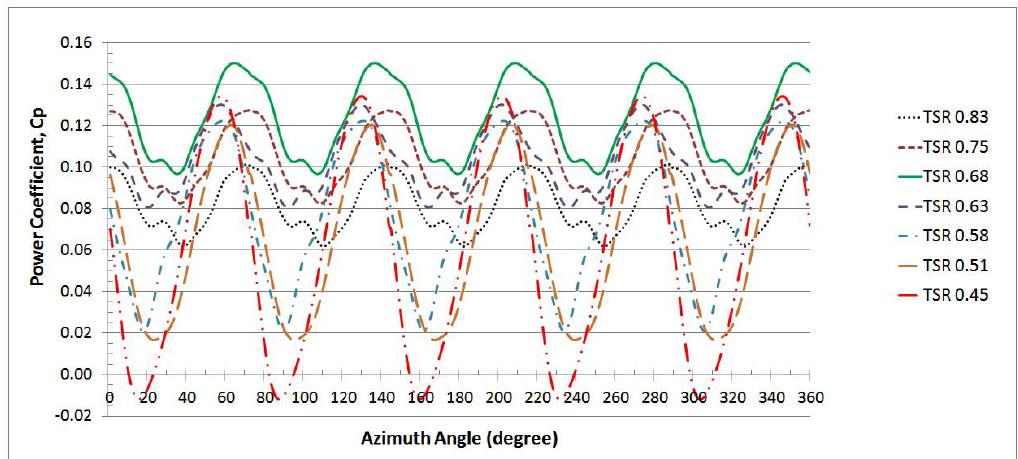
Figure 22. Power coefficient of a single blade of the VAWT versus azimuth angle.